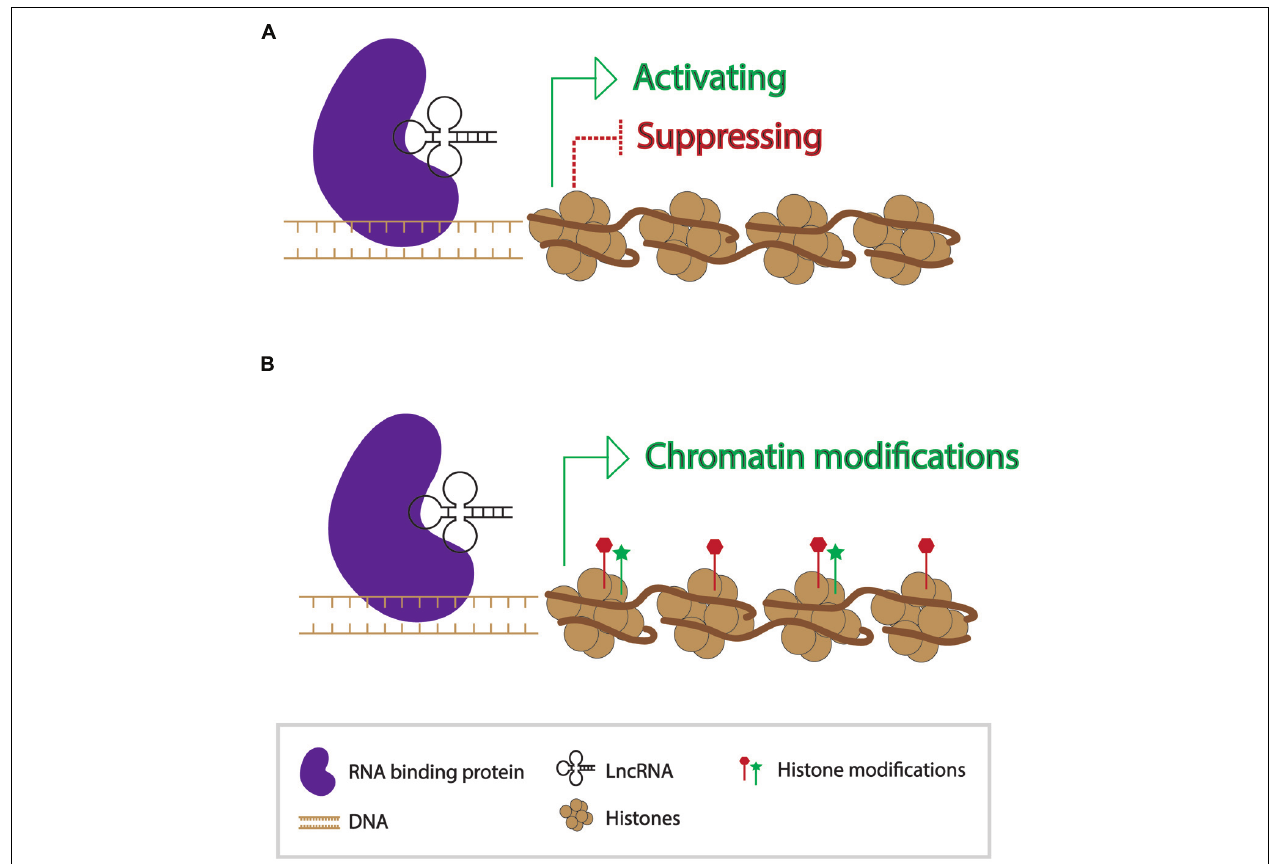
FIGURE 2 | Modes of action of long non-coding RNAs in transcriptional regulation of genes. (A) Long non-coding RNAs can participate in gene activation and suppression. (B) Long non-coding RNAs can act as a guide for chromatin modifications.